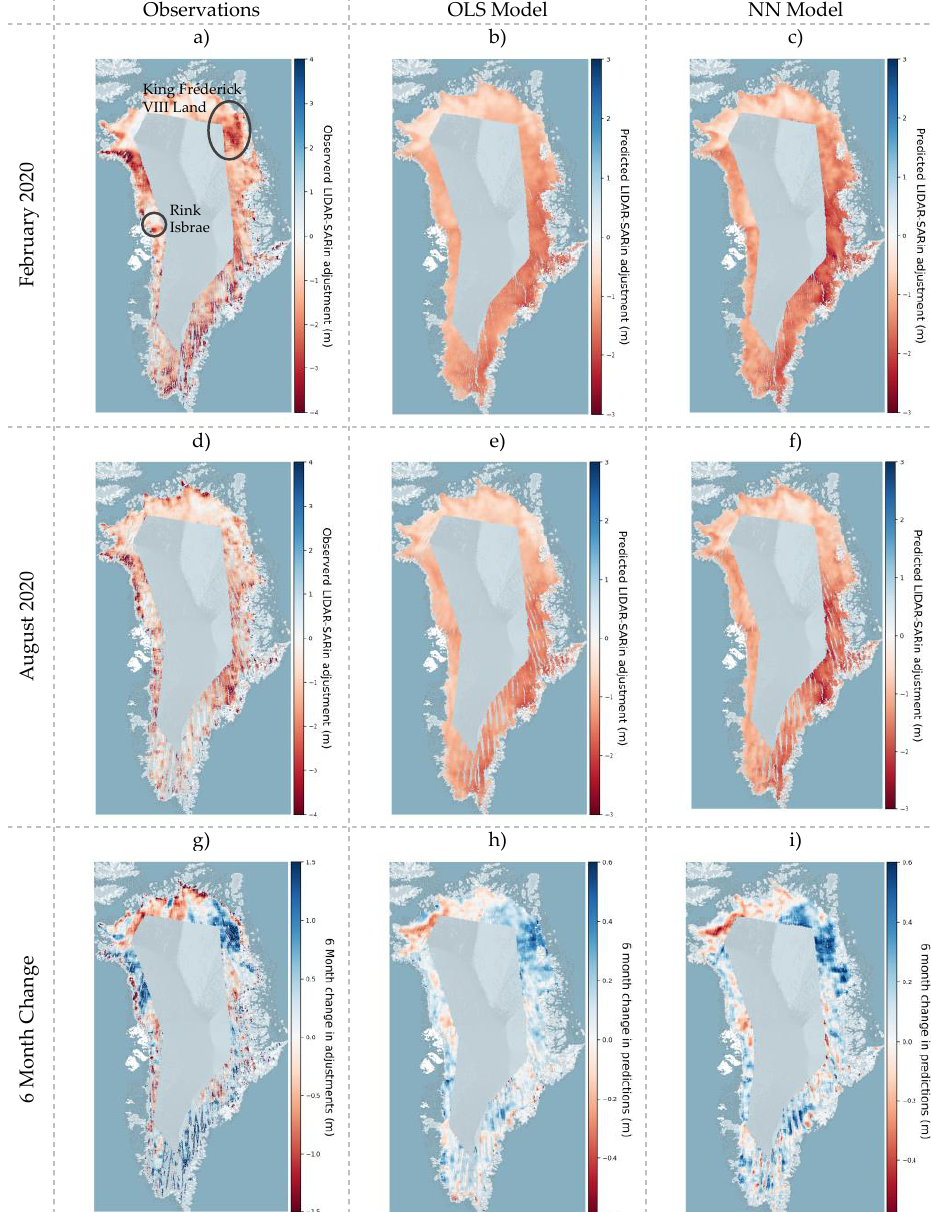
Figure 3. Gridded maps of observed LIDAR-SARIn differences for February 2020 ( a ) and August 2020 ( d ) and their difference ( g ), and equivalent model predictions from the ordinary least squares model ( b , e , h ), and from the neural network model ( c , f , i ). Note that the scale bars have been adjusted between observations and model predictions to allow for a clearer visual comparison of broad trends.